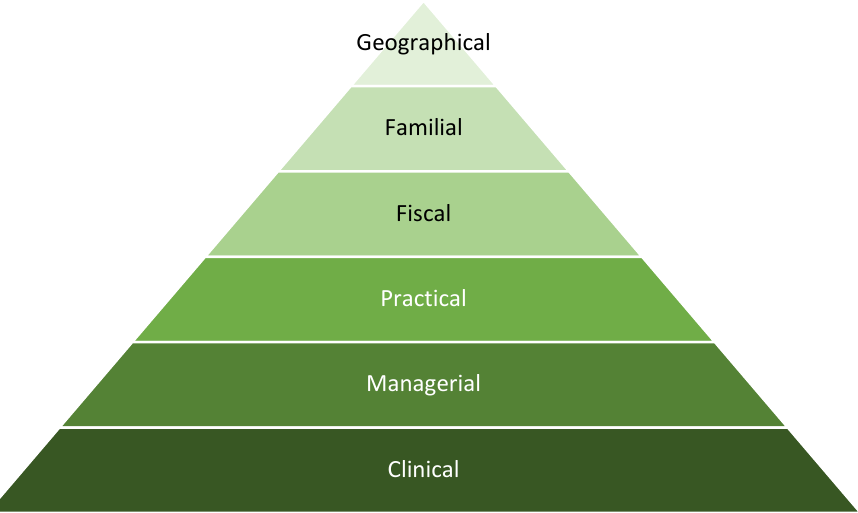
Figure 2. The Rural Nursing Workforce Hierarchy of Needs model or hierarchy of workforce need.